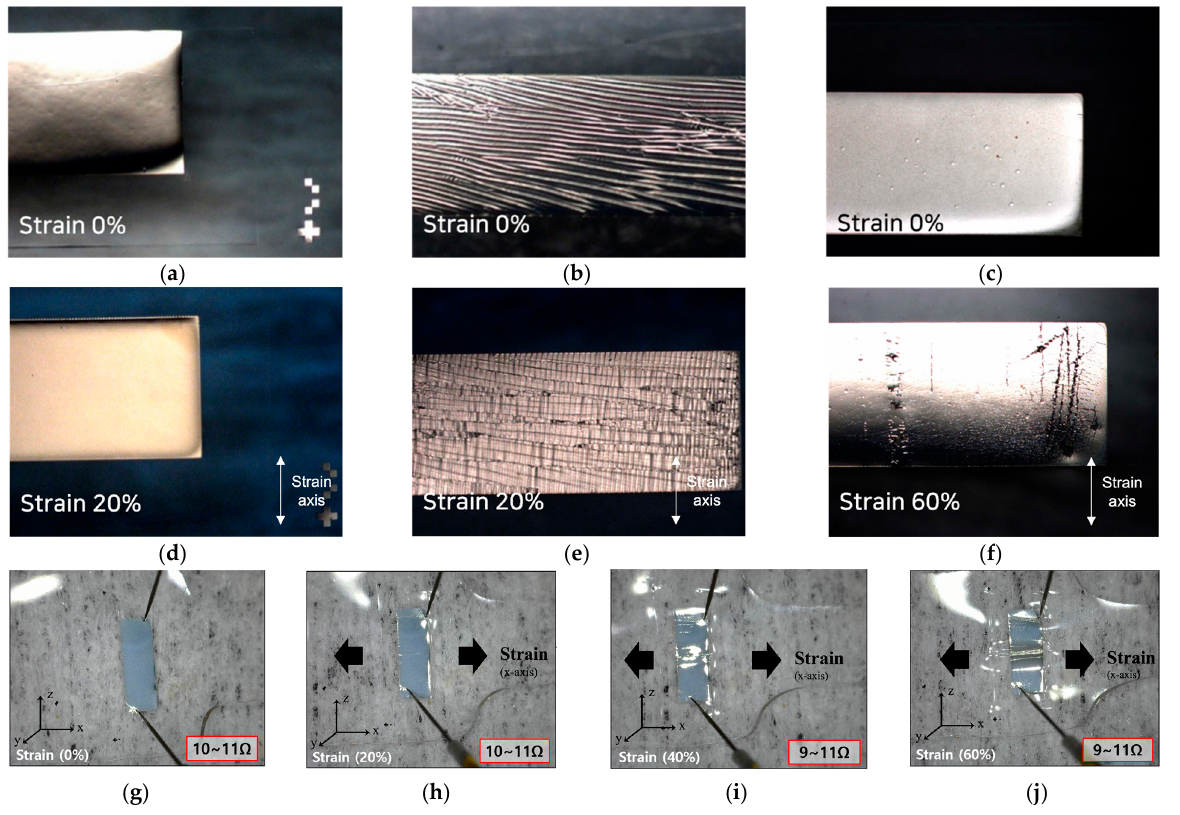
Figure 5. An equivalent circuit model of dumbbell shape.